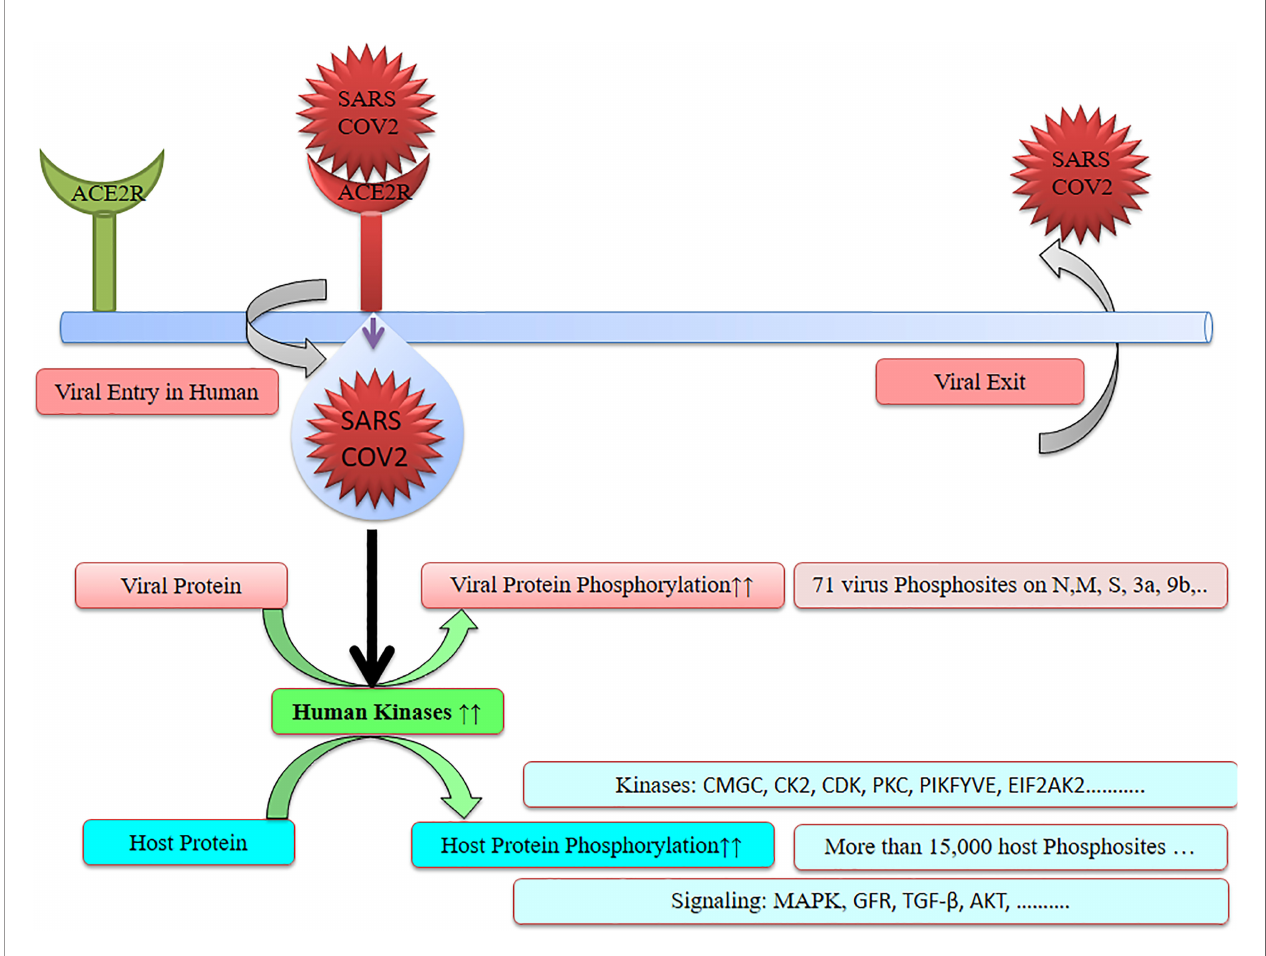
FIGURE 1 | SARS-CoV-2 causes heavy